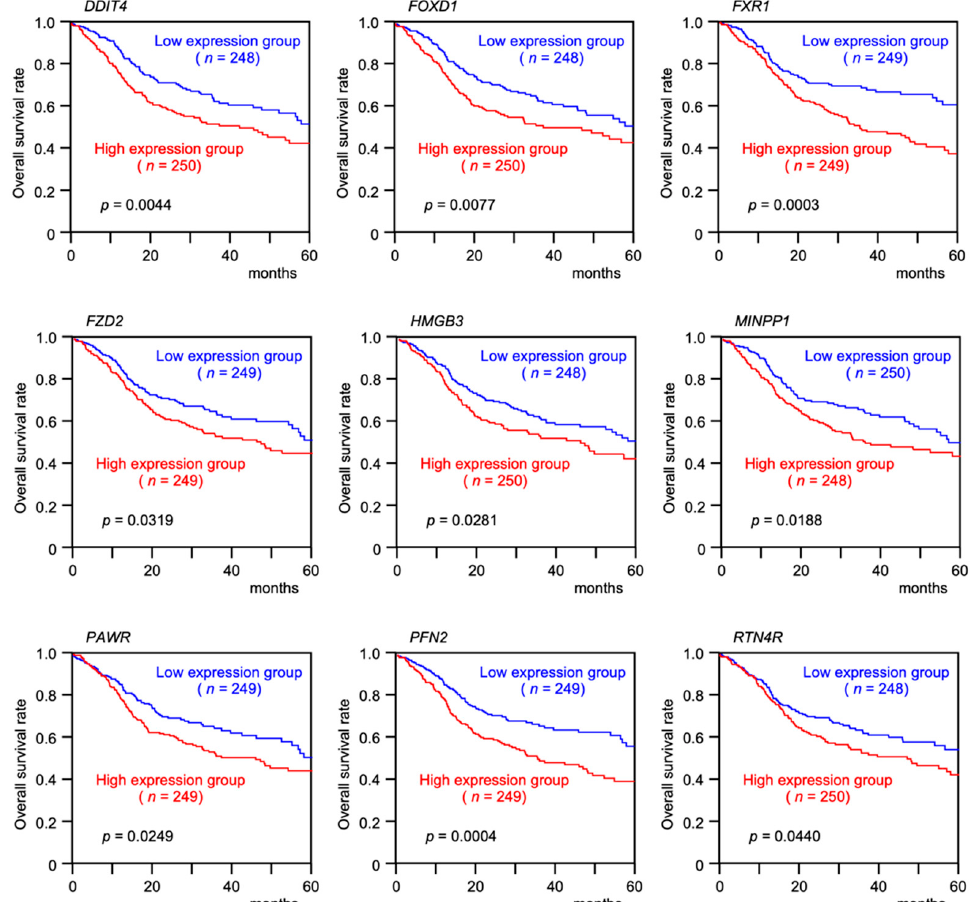
Figure 7. Clinical significance of nine target genes ( DDIT4 , FOXD1 , FXR1 , FZD2 , HMGB3 , MINPP1 , PAWR , PFN2 , and RTN4R ) according to TCGA-HNSC data analysis. Kaplan–Meier curves of the 5-year overall survival rates according to the expression of each gene are presented. High expression levels of all nine genes were significantly predictive of a poorer prognosis in patients with HNSCC. Patients were divided into two groups according to the median gene expression level: high and low expression groups. The red and blue lines represent the high and low expression groups, respectively. Table 2. Results of Cox regression analysis of overall survivals in five years in TCGA-HNSC. Monovariate